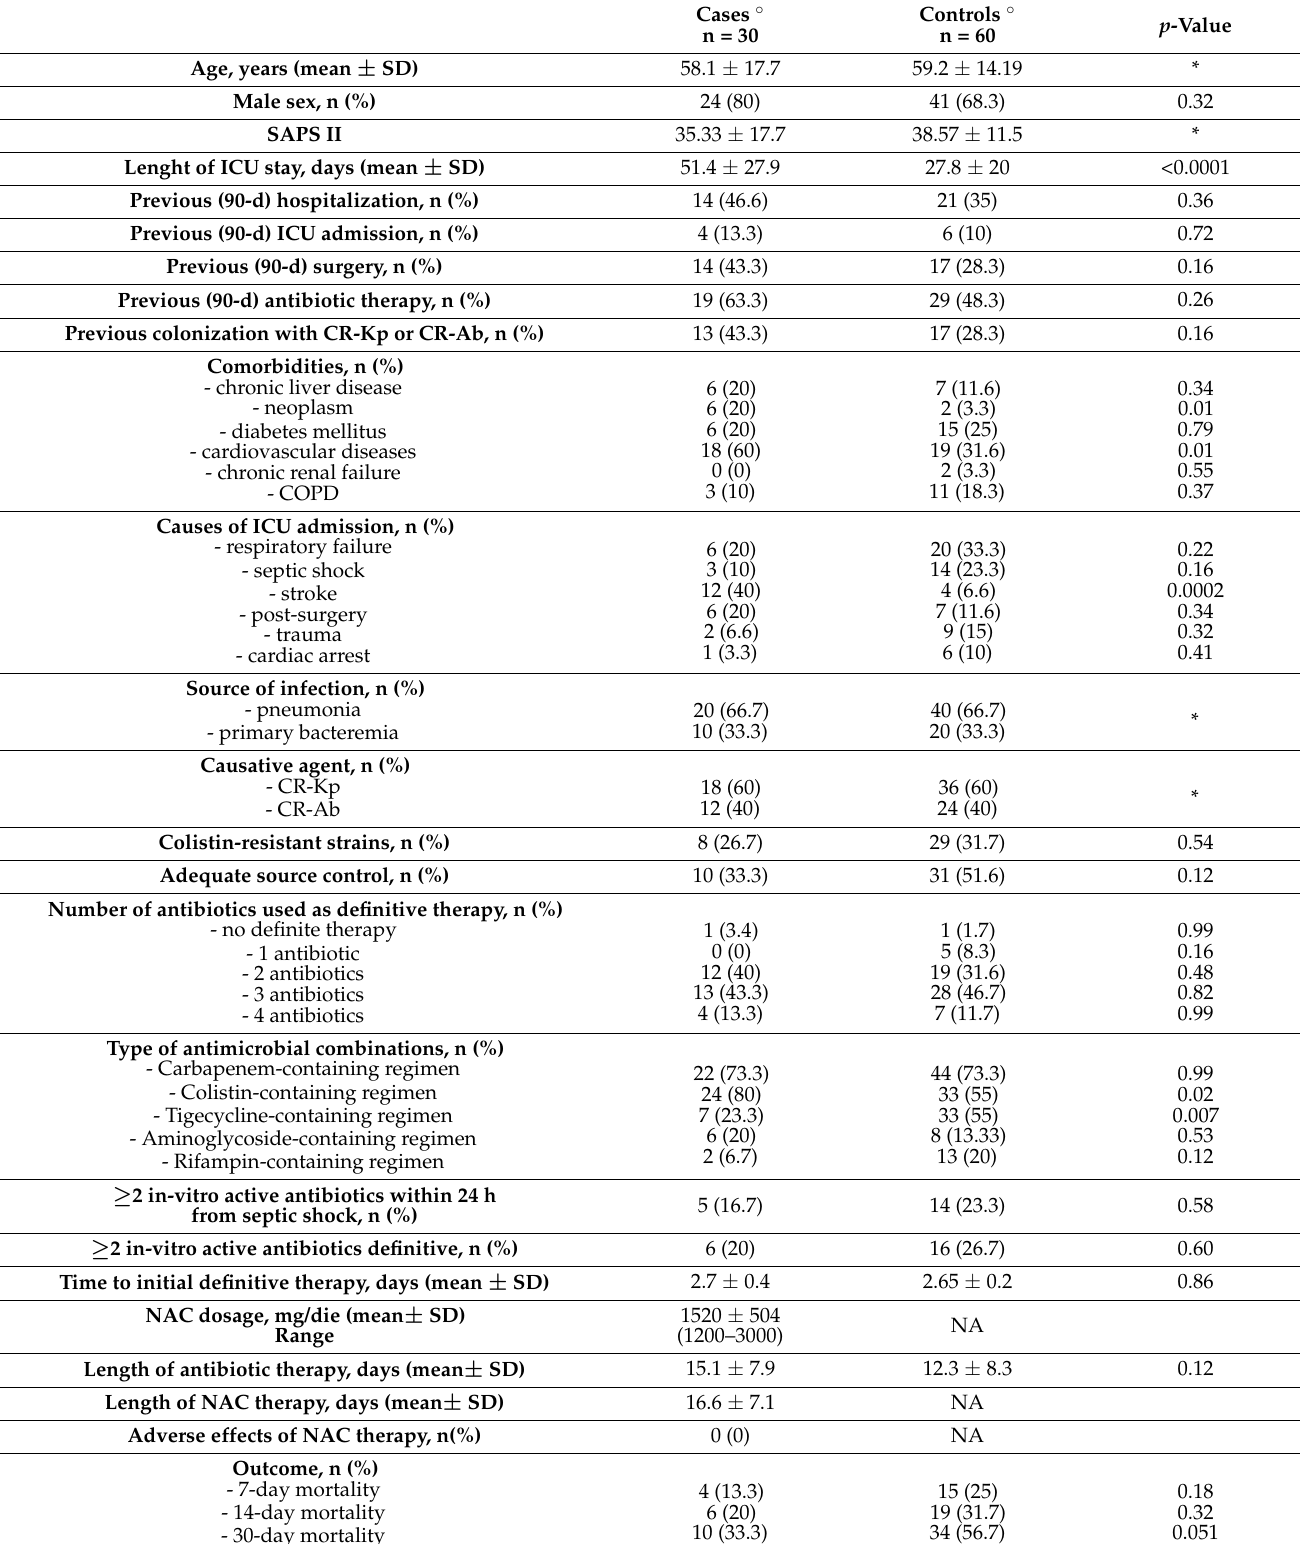
Table 1. Characteristics of patients with septic shock caused by carbapenem-resistant Klebsiella pneumoniae (CR-Kp) and Acinetobacter baumannii